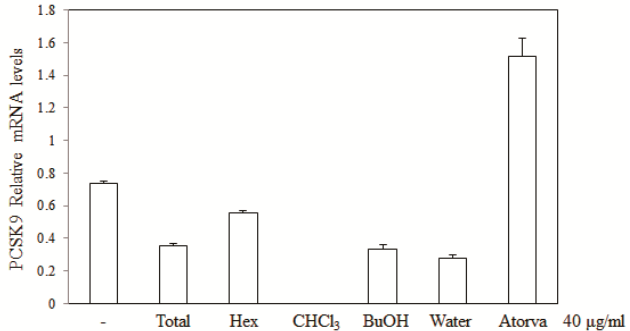
Figure 1. The effects of (total) methanol extracts, hexane (Hex), chloroform (CHCl 3 ), butyl alcohol (BuOH) and aqueous fractions of S. baicalensis on PCSK9 mRNA expression in HepG2 cells. (Atorva = Atorvastatin).